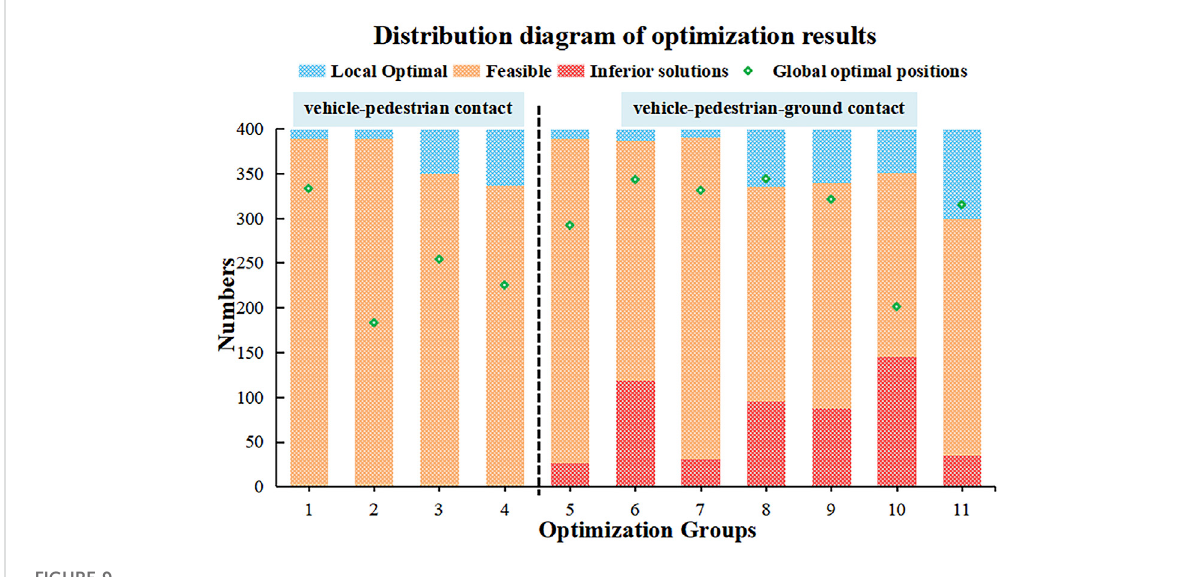
FIGURE 9 Distribution of the number of different quality solutions in the 11 optimization groups.